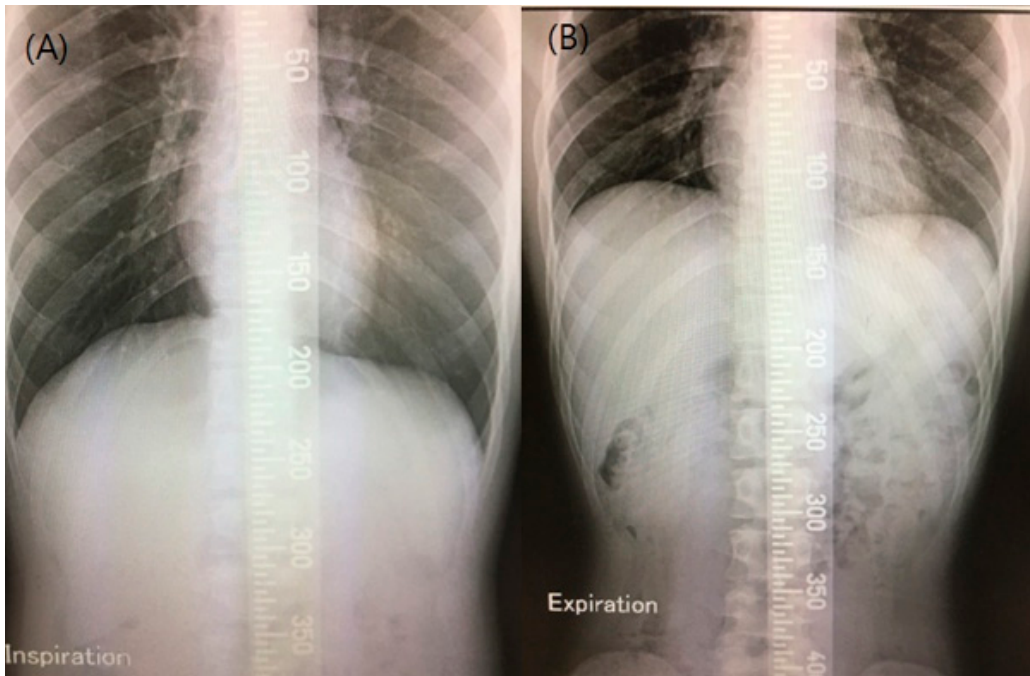
Figure 1. Measurements of diaphragm mobility. Chest radiography in anteroposterior view during maximal inspiration and maximal expiration conducted on the same film. ( A ) Chest X-ray taken during a maximal inspiratory maneuver. ( B ) Chest X-ray taken during a maximal expiratory maneuver.